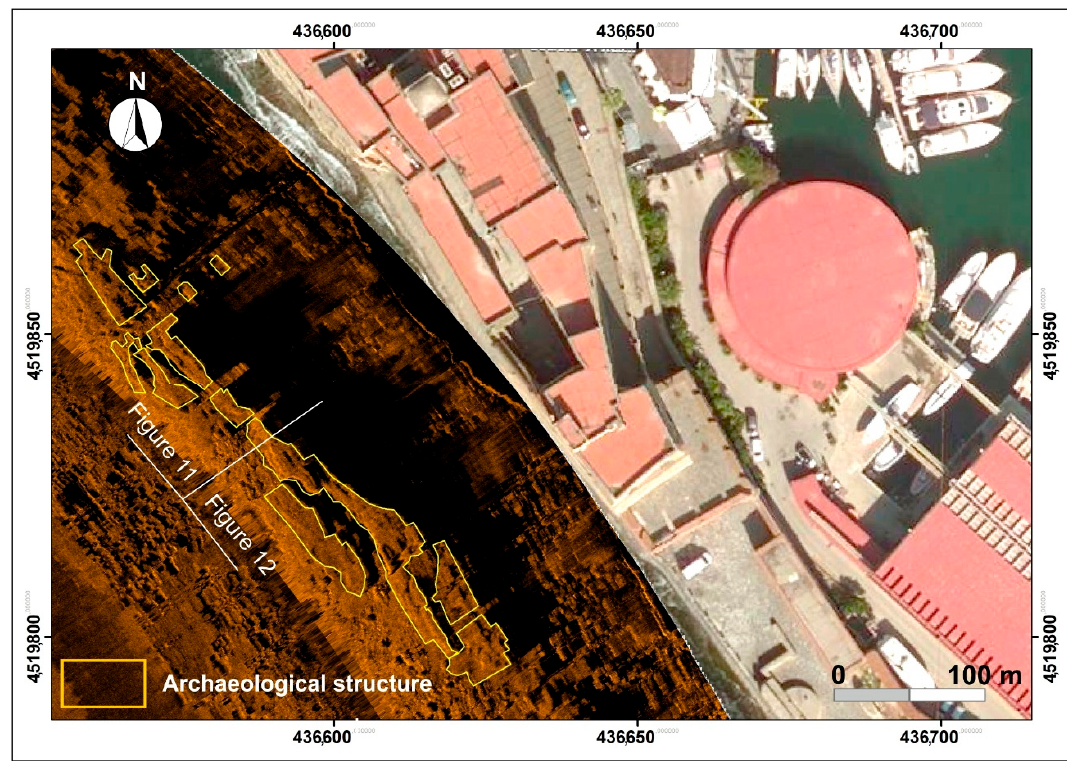
Figure 11. Map of the SSS mosaic archaeological interpretations.